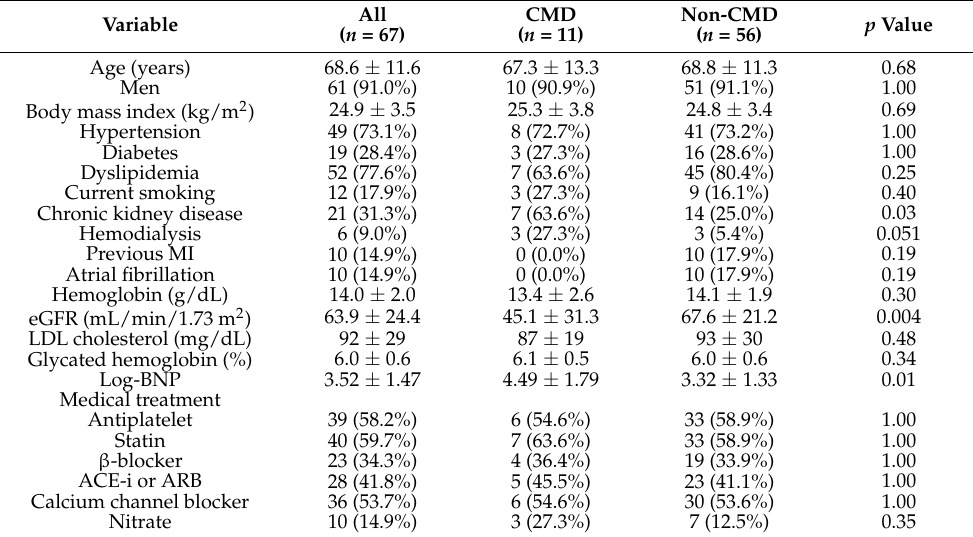
Table 3. Baseline characteristics in patients with physiological testing using